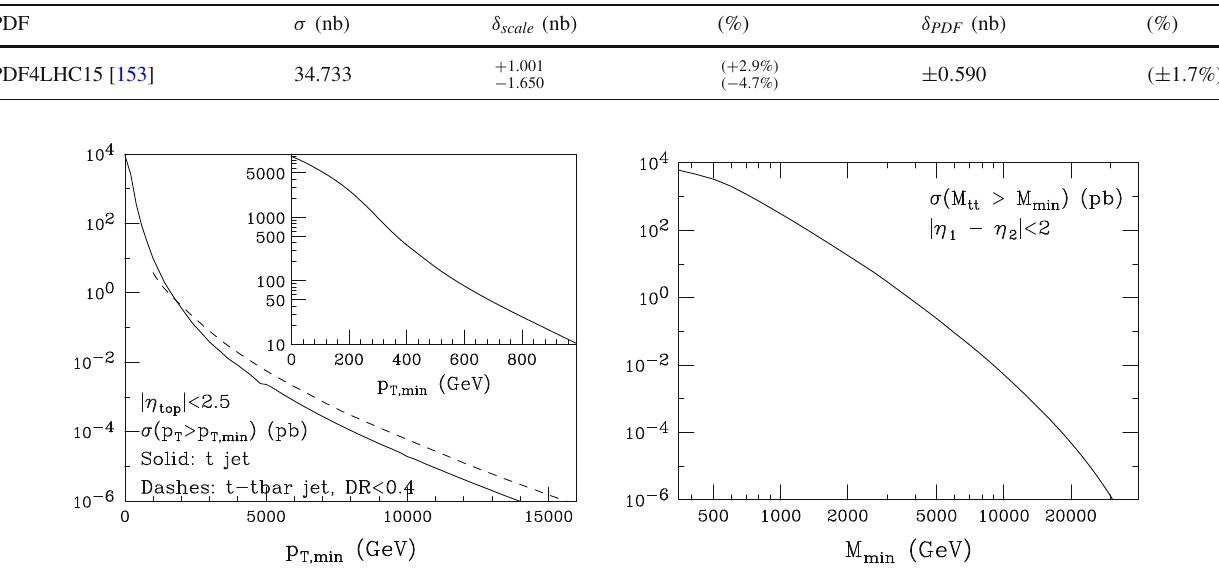
Table 6.1 Total t¯t production cross sections, at NNLO, for m top = 173 . 3 GeV. The scale uncertainty is derived from the 7 scale choices of μ = k m = 0 . 5 , 1 , 2 and 1 / 2 < μ R , F top , with k